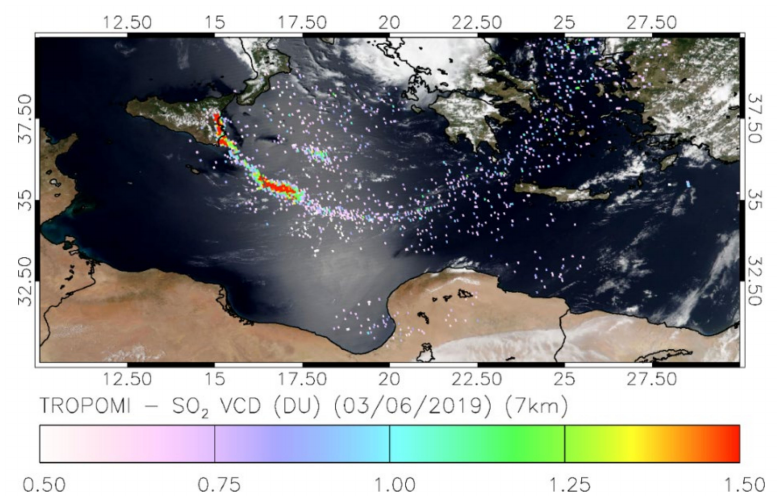
Figure 13. SO 2 vertical column (in DU) from the TROPOMI instrument aboard Sentinel-5P across Etna’s plume on 3 June 2019 at 12:00 UTC (see Section 3.3 for details). The RGB background image is from VIIRS aboard Suomi-NPP (NASA worldview; https://worldview.earthdata.nasa.gov/) which has an overpass time very close (less than 5 min) to